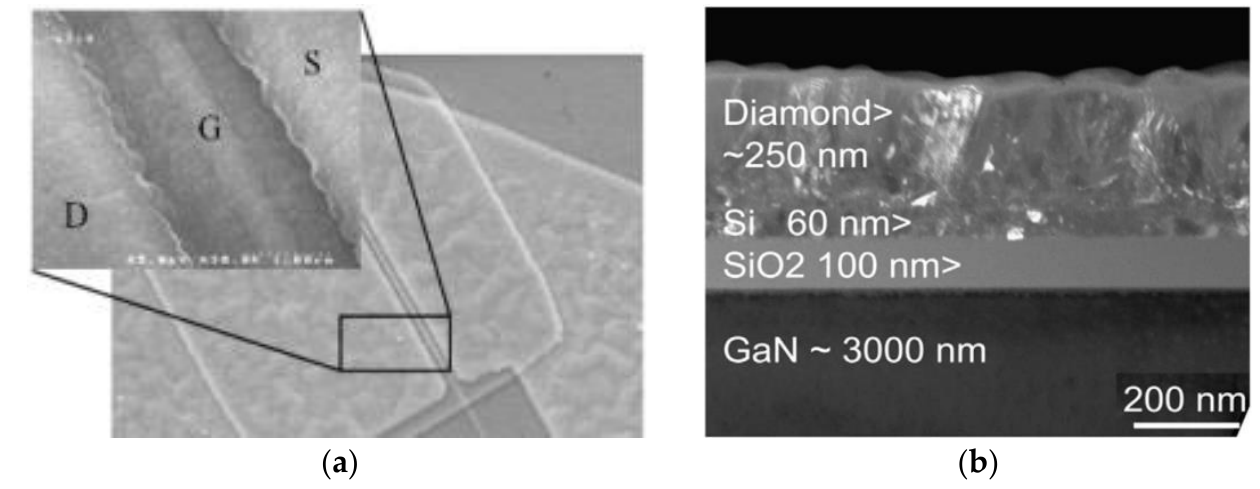
Figure 16. ( a ) SEM top view of a GaN HEMT coated with a 0.5 µm-thick NCD layer. ( b ) TEM cross section of the NCD film showing no voids at the passivation/growth interface (reprinted from Diam. Relat. Mater., vol. 20, no. 4, M. Alomari et al., “Diamond overgrown InAlN/GaN HEMT,” pp. 6 04 – 608 [148], Copyright 2011, with permission from Elsevier).